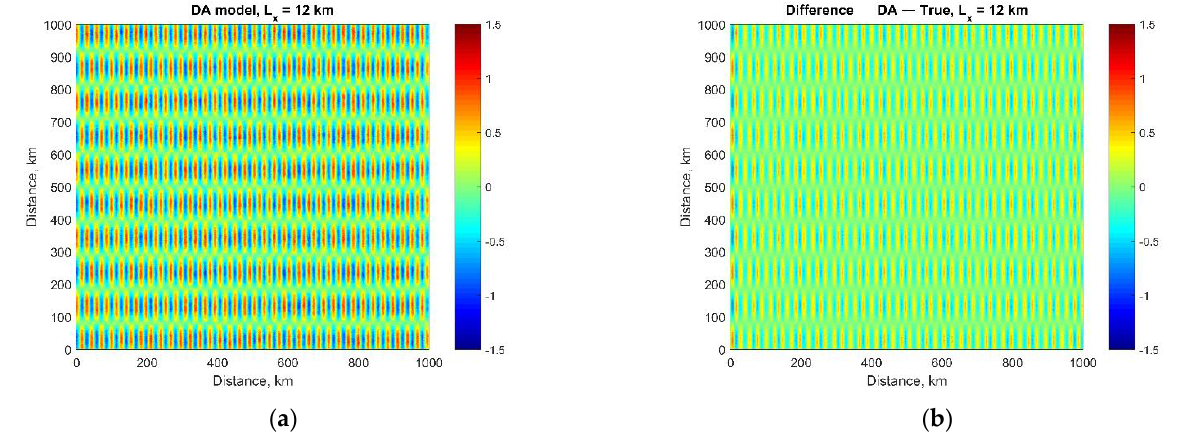
Figure 11. Maps for the multiple eddies case with width 𝐿 𝑥 = 12 km: ( a ) NDA assimilated model, ( b ) difference between NDA assimilated model and true field. Parameters of the non-assimilated model are the same as in Figures 9 and 10.